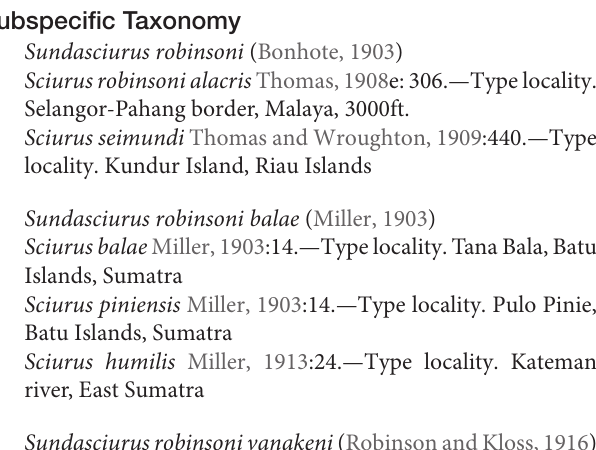
We inferred a posterior probability of 1.0 for all species postulated by the ∗ BEAST guide tree except S. fraterculus and S. l.